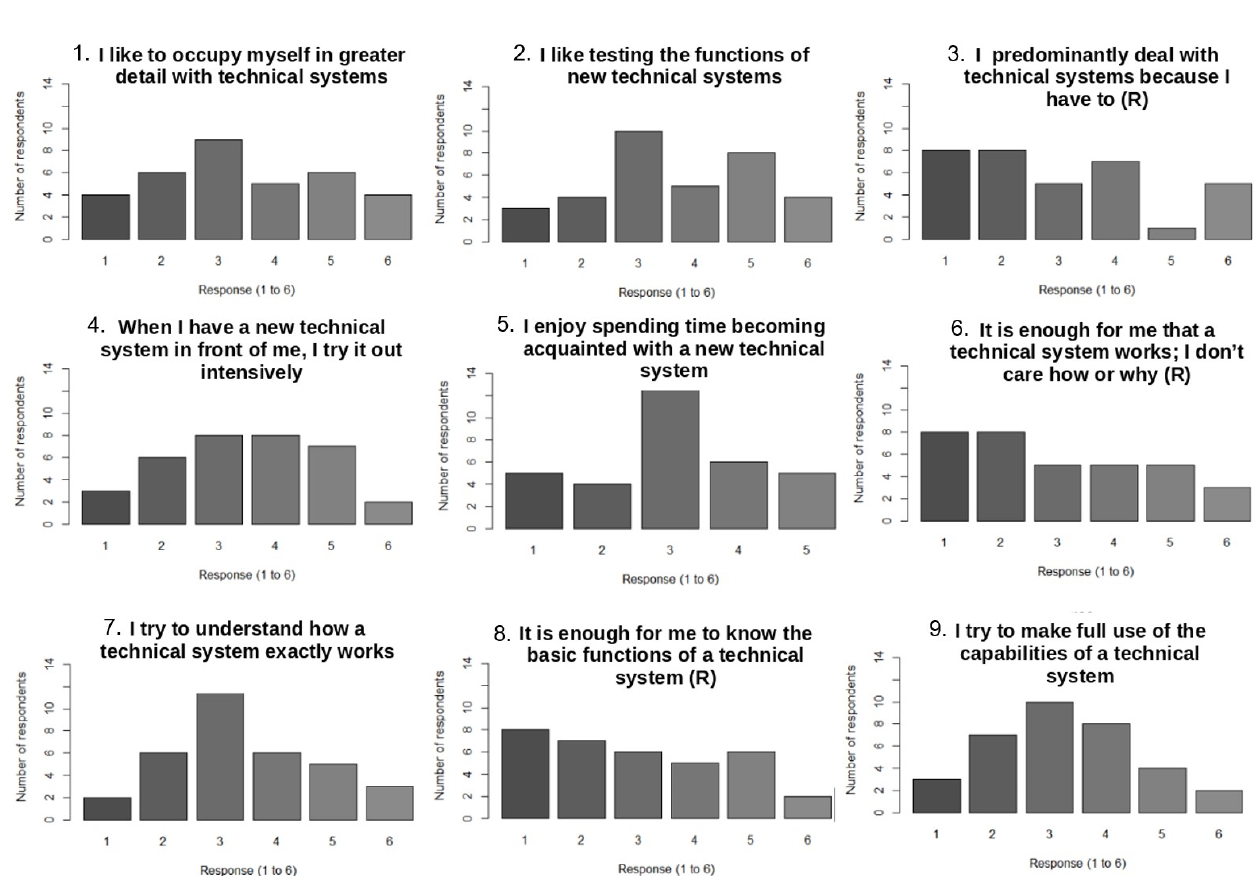
Figure 4. Results for different items of the ATI scale ( n = 34; R = reverse coded). Furthermore, the correlations between the items were all positive. The third and eighth item (reversed) had the lowest correlations with other items, with values between